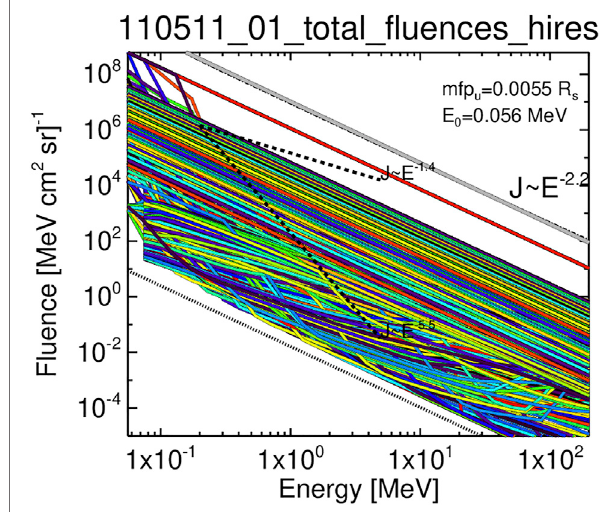
FIGURE 9 | Resulting fl uence spectra for all shock-crossing fi eld lines modeled with the SPREAdFAST DSA model for the May 11, 2011 event. The sum total of all fl uences is also plotted with a light gray color, and the power law index to its fi t is shown (in this case, δ = − 2.2.) We also show the input spectrum fl uence with a dotted line below the colored output fl uence lines. The plot also features reference power law slopes corresponding to shock density jumps r = 1.2 and r =